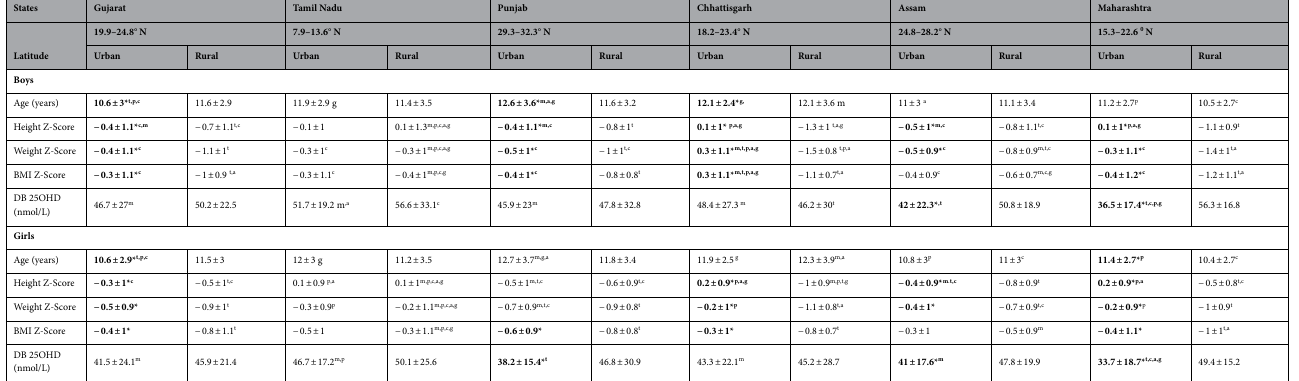
Table 1. State, region (urban/rural) and gender-wise demographic and anthropometric characteristics with vitamin D concentrations of the study population. Significant values are in [bold]. *Level of significance ( p < 0.05) between urban and rural regions of the same state. Interstate significances ( p < 0.05) are marked as state initials where m = Maharashtra, a = Assam, p = Punjab, c = Chhattisgarh, t = Tamil Nadu and g = Gujarat BMI = Body mass index (kg/m 2